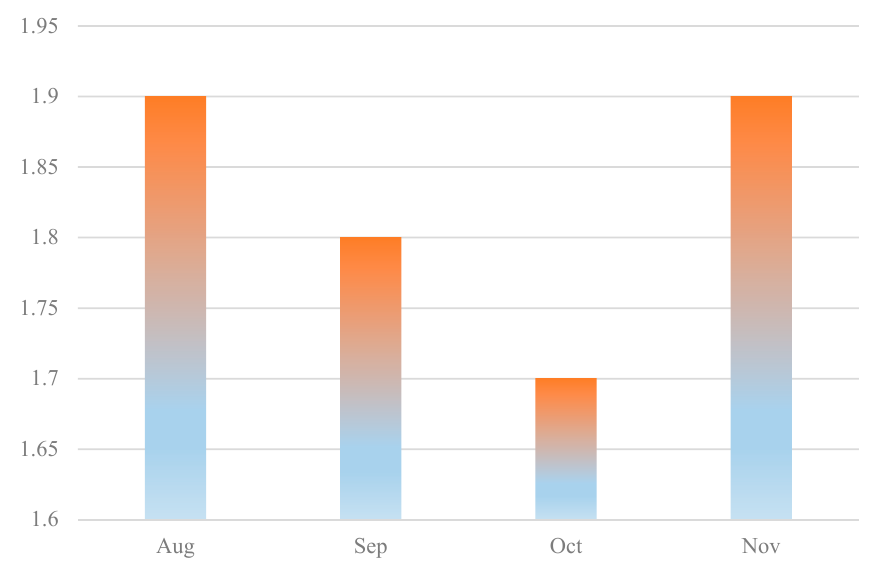
Figure 16. Percentage of the energy supply by the PV subsystem.